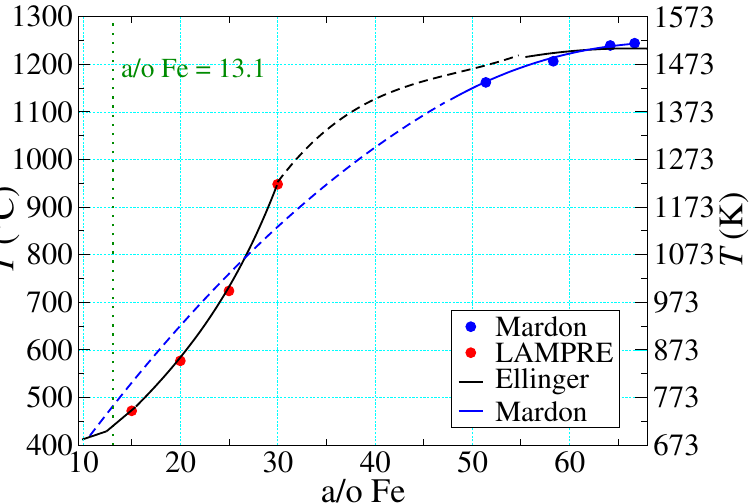
Figure 2. Pu 6 Fe liquidus curves according to References [5,7,10]. Points are data, solid curves are fits to data, and dashed curves are interpolations between data sets. The solid/dashed distinctions are as they appear in the original references. Our revised STR composition is indicated by the vertical dotted